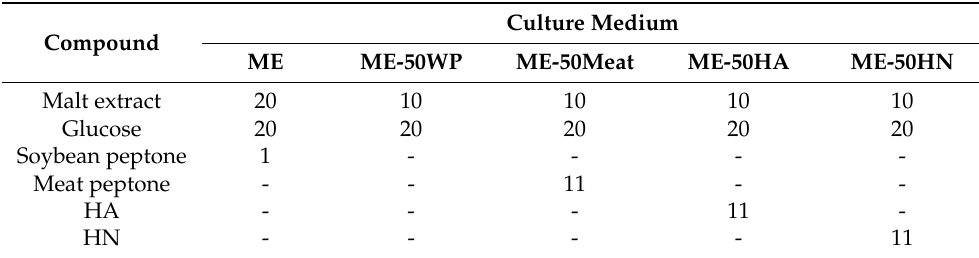
Table 4. Composition of the culture media (g/L) tested based on MEA for the evaluation of HA and